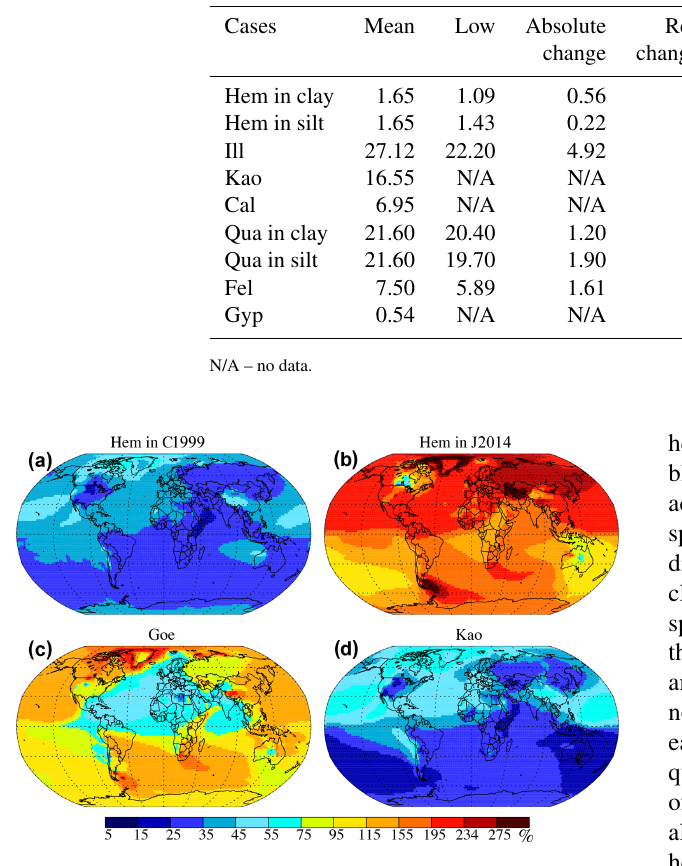
Figure 6. Relative change (in percentage) of simulated mass frac- tion for hematite (hem) C1999 ( a ; in the clay-sized category) and J2014 (b) , goethite ( c , goe), and kaolinite ( d , kao) in CAM5 from base to high bounds of their soil distribution. Relative change in per- centage is calculated as (high bound-base) / (base) × 100. The mean distributions have been shown previously (Scanza et al., 2015; Perl- witz et al.,